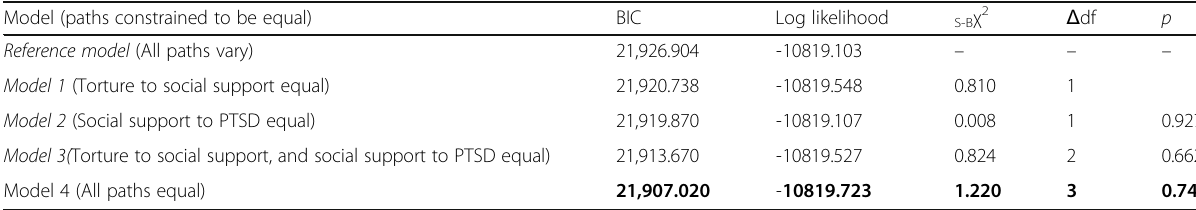
Table 3 Comparison of mixture models of torture exposure, social support and PTSD with equality constraints across gender placed on different structural paths within the models Model (paths constrained to be equal) BIC Log likelihood S-B χ 2 Δ df p Reference model (All paths